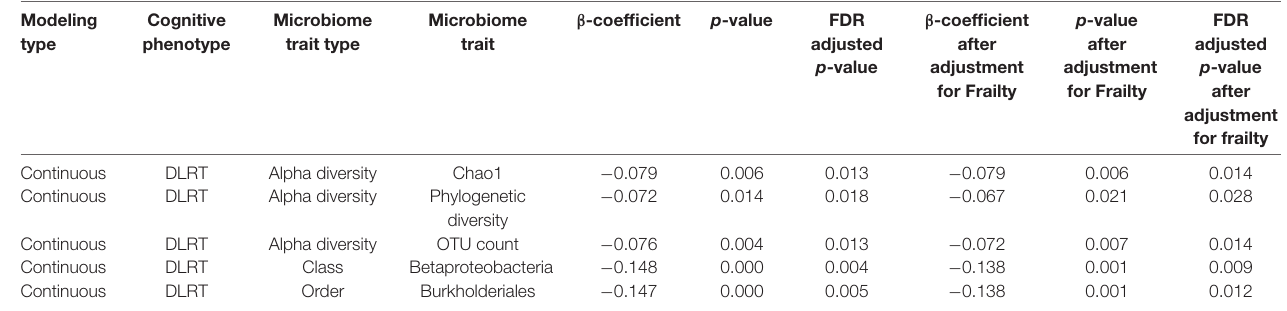
TABLE 3 | Significant associations between cognitive measures and the gut microbiome, when excluding individuals using antibiotics or proton pump inhibitors (PPIs) and including diet as a